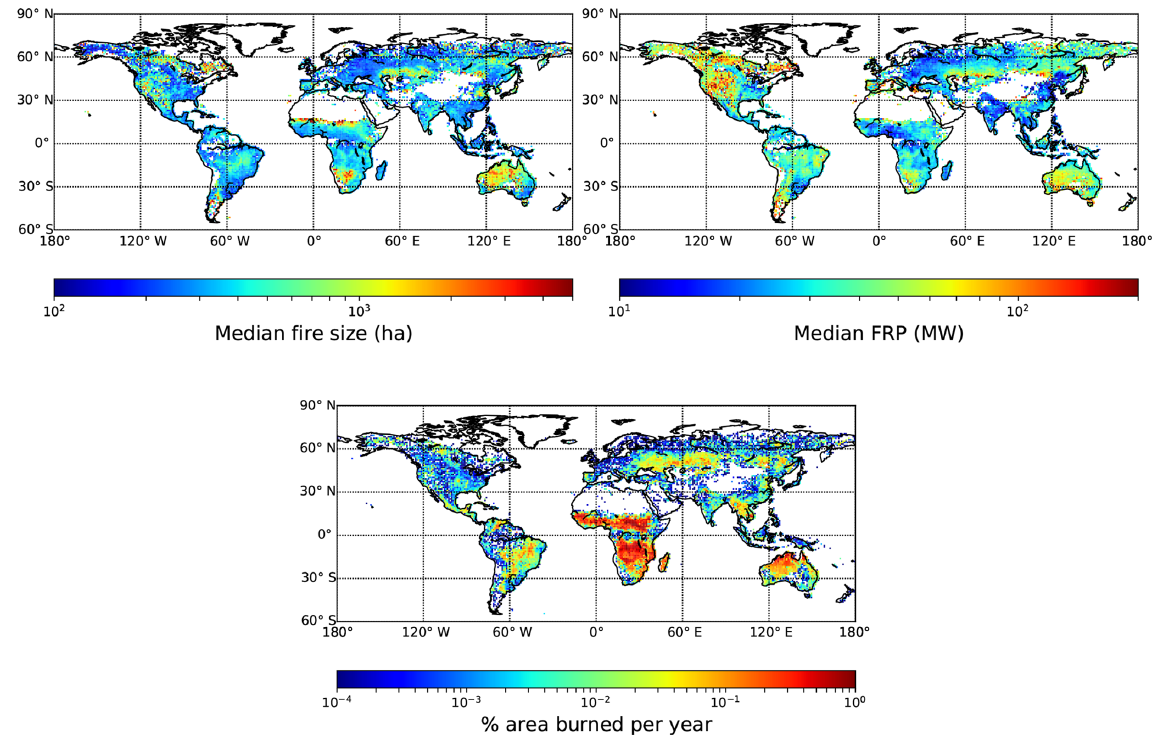
Figure 1. Median fire size (in hectares), median fire radiative power from the FRY database (derived from MCD64A1 with a cut-off of 14 days) and percentage of burned area each year (from